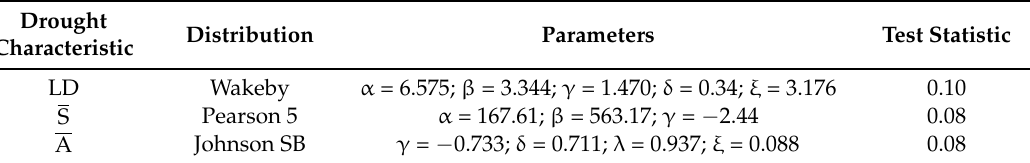
Table 7. Kolmogorov–Smirnov statistics and parameters of best theoretical CDF distributions (Figure 3) for the drought characteristics LD, S, and